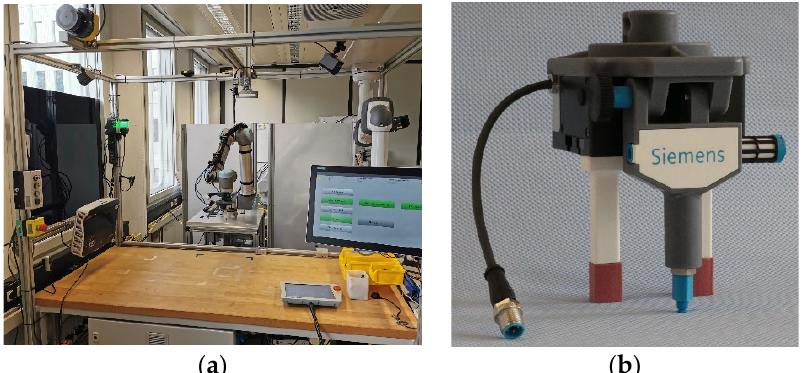
Figure 8. The work cell for the use ‐ case. ( a ) The work cell considered in the evaluation use ‐ case. ( b ) The EE integrated in the use ‐ case. A UR 10 CB3 was used for the implementation, which allowed for the implementation of the PFL risk mitigation. Moreover, the EE employed was a self ‐ designed device, which was also proven to be safe by performing collision testing to determine a safe opera ‐ tion speed of the